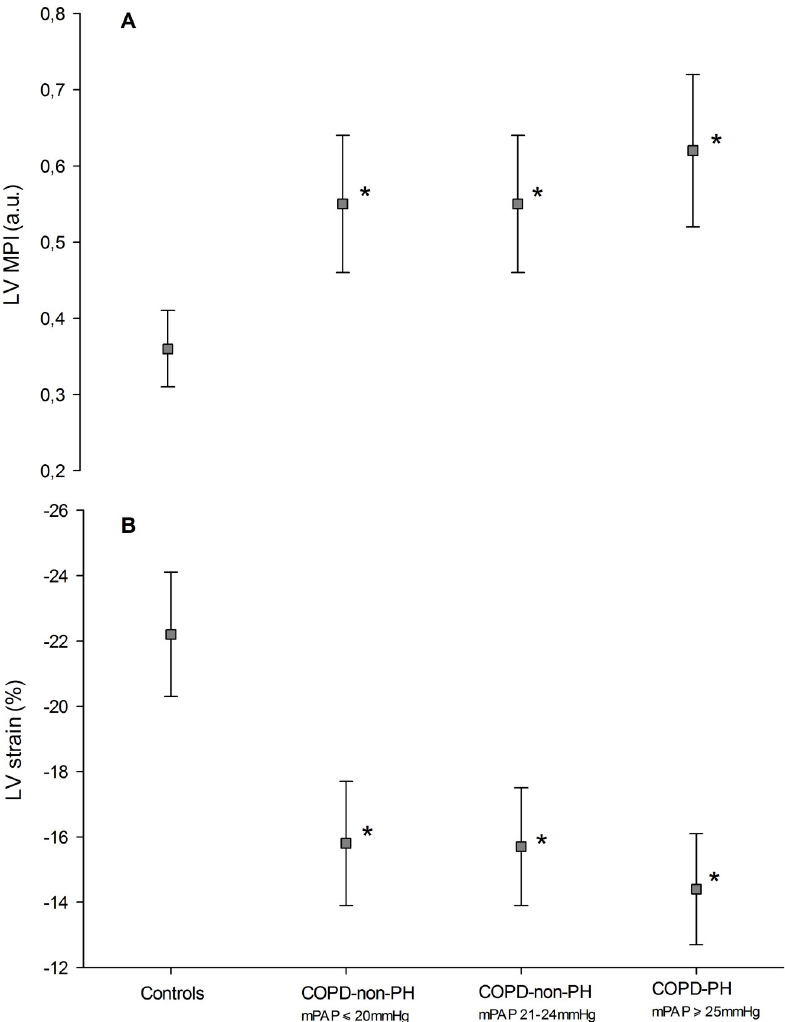
Fig 1. LV myocardial performance index and LV strain in controls, COPD patients with normal and intermediate pulmonary pressure and with pulmonary hypertension. Similar findings of LV dysfunction by LV myocardial performance index (MPI) (panel A) and LV strain (panel B) in 100 COPD patients divided in three groups; those with normal ( � 20 mmHg) and borderline (21–24 mmHg) mean pulmonary pressure (mPAP) and those with pulmonary hypertension ( � 25 mmHg) compared to 34 healthy controls. � significantly different from controls (p < 0.01), † significantly different from COPD-non-PH with mPAP � 20 mmHg and mPAP 21–24 mmHg (both p < 0.05).